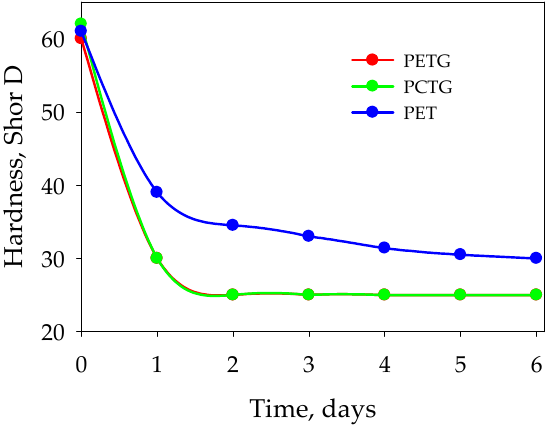
Figure 6. Material hardness during the sorption of ethyl acetate.